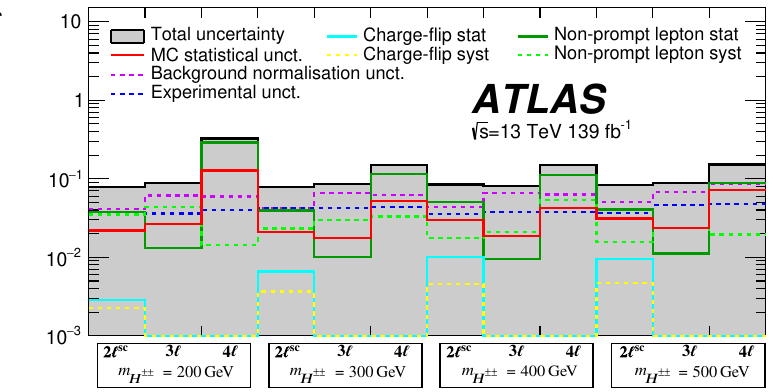
Figure 6 . Contributions from different categories of uncertainties relative to the expected back- ground yields in the defined SRs. The uncertainties are shown for the combination of the individual channels of the 2 ‘ sc , 3 ‘ and 4 ‘ SRs. The m = 220 GeV , 350 GeV and 450 GeV signal hypo- H ±± theses use the signal regions defined for the m = 200 GeV , 300 GeV and 400 GeV signal. The H ±± = 550 GeV and m = 600 GeV signal hypotheses use the signal regions defined for the m H ±± H ±± = 500 GeV signal. The SRs are indicated along the horizontal m H ±±